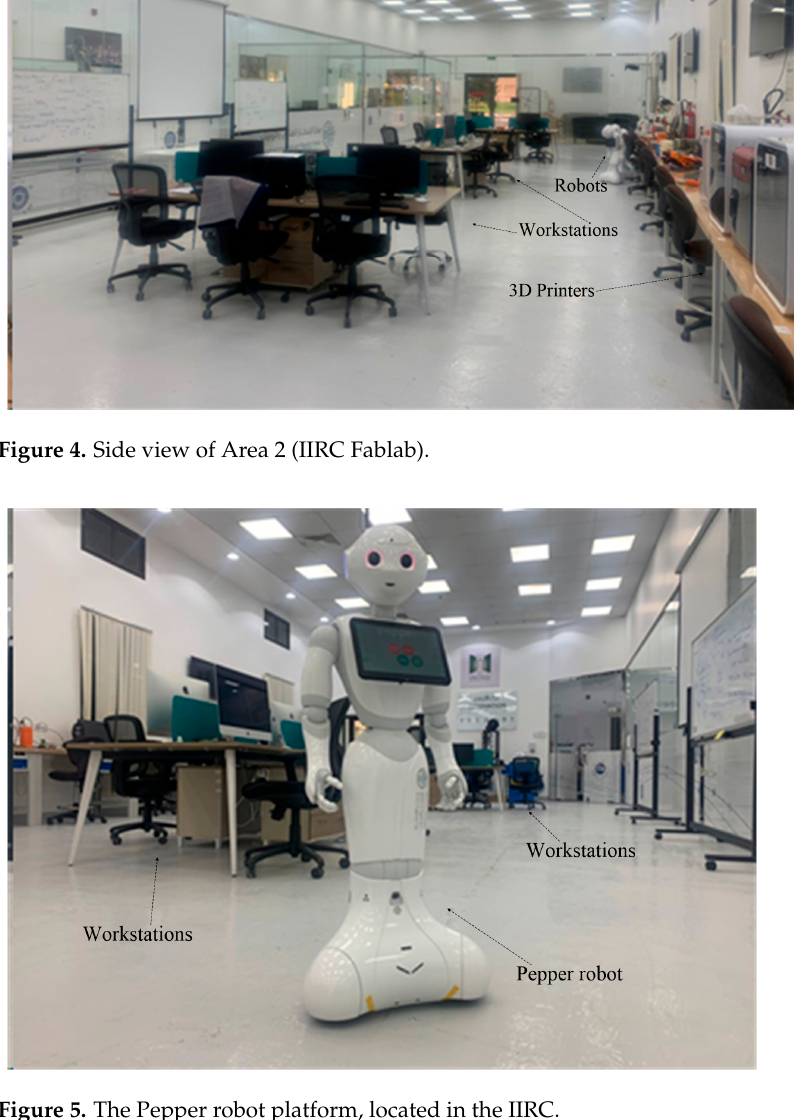
Figure 5. The Pepper robot platform, located in the IIRC.